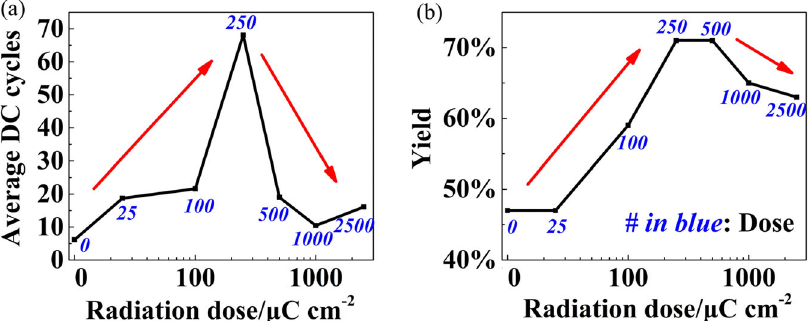
Fig. 7 The irradiation effect on the reliability performance of MoS 2 devices. a The average DC cycle number for the devices with different radiation doses. The average DC cycles that one device can survive increase from ~6 cycles for unirradiated devices to ~68 cycles as the dose increases to 250 μ C/cm 2 , and then return back to a lower level at higher doses. b The yield for the devices with different radiation doses. The yield increases from ~47% for unirradiated device to ~71% as the dose increases to 250 μ C/cm 2 and 500 μ C/cm 2 , and then returns back to a lower level at higher